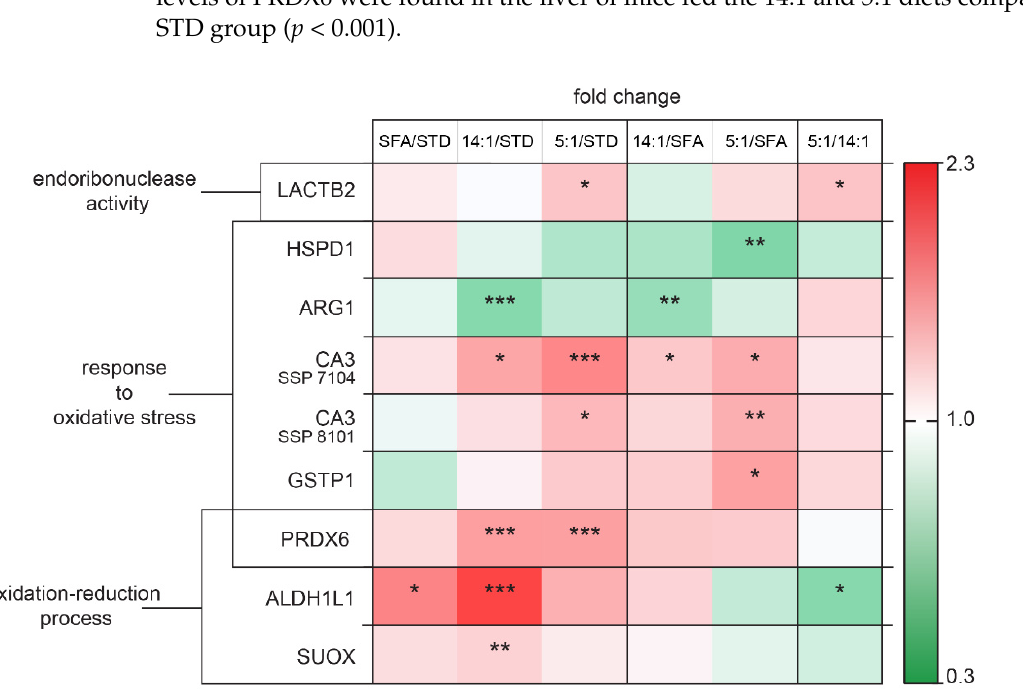
Figure 9. Changes in the abundance of proteins involved in oxidative stress regulation. The statistically significant ( p < 0.05) value of the average intensity of the SFA, 14:1 and 5:1 groups compared to the STD group; the 14:1 and 5:1 groups compared to the SFA group; the 5:1 group compared to the 14:1 group. The significance of differences estimated using the model (1). *— p < 0.05; **— p < 0.01; ***— p < 0.001.